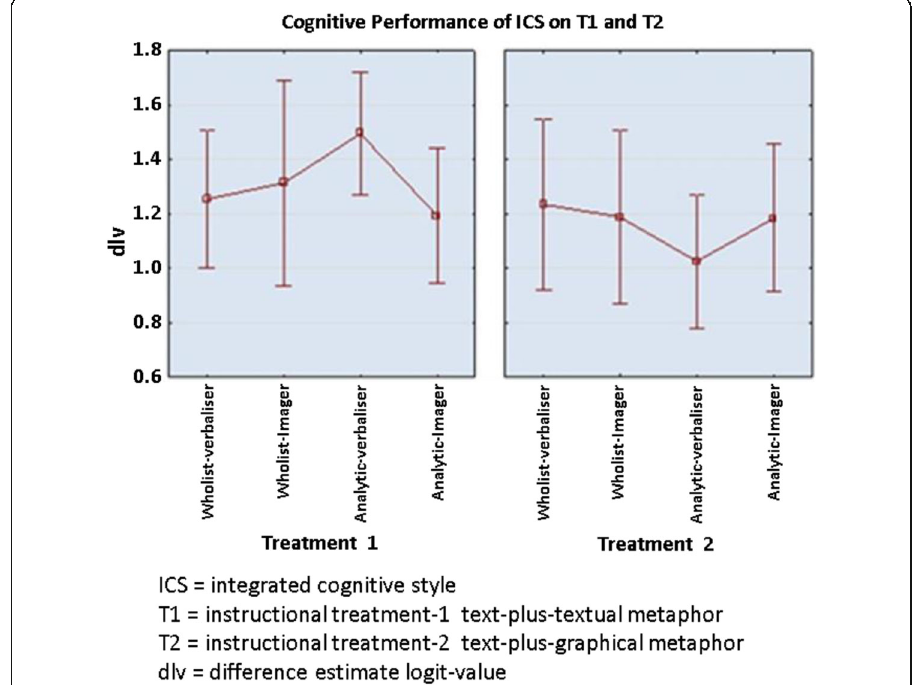
Fig. 12 Cognitive performance of ICS groups with T1 and T2 (Mohamad 2012 p.177). This figure shows the results in a graphical representation of the interactive nature of the cognitive performance of integrated cognitive style (ICS) wholist-verbaliser, wholist-imager, analytic-verbaliser, analytic-imager for the two instructional treatments: T1 (text-plus-textual metaphor) and T2 (text-plus-graphical format) based on average